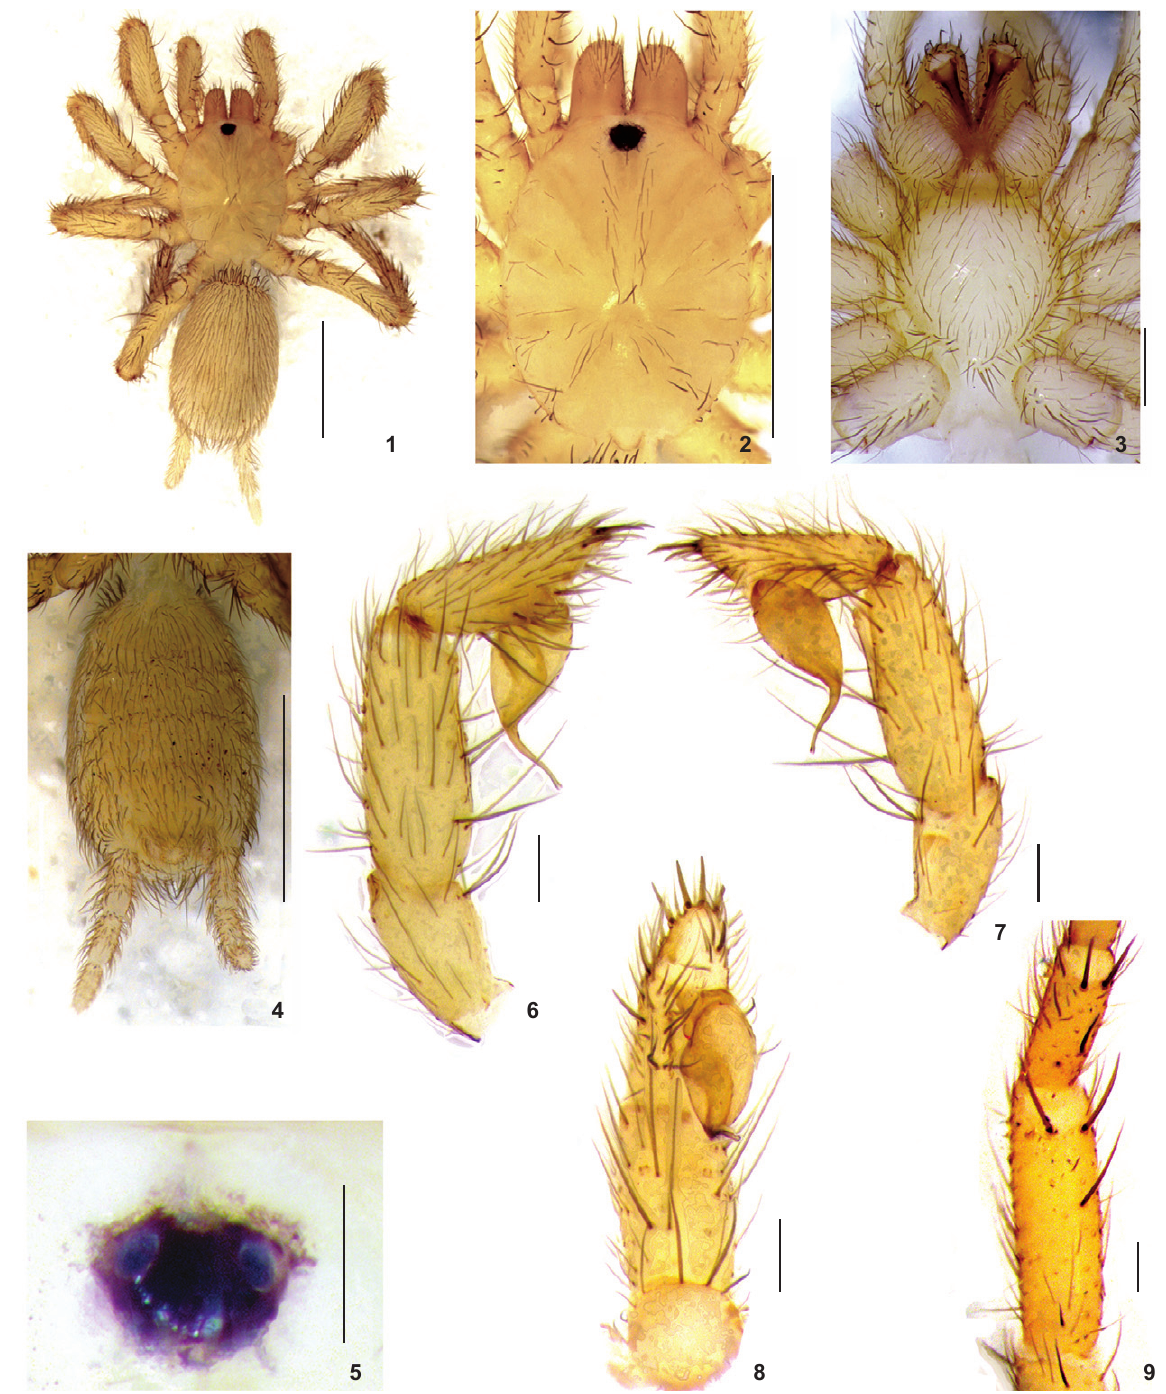
Figures 1-9. Masteria emboaba sp. nov. Holotype male (MNRJ 4540) (1) habitus; (2) carapace and chelicerae; (3) sternum, maxillae, chelicerae, coxae and labium; (4) abdomen, ventral; (5) eye tubercle; (6-8) left male palp, (6) retrolateral, (7) prolateral, (8) ventral; (9) left leg I, ventral. Scale bars: 1-2, 4 = 1 mm, 5-9 = 0.1 mm, 3 = 0.5